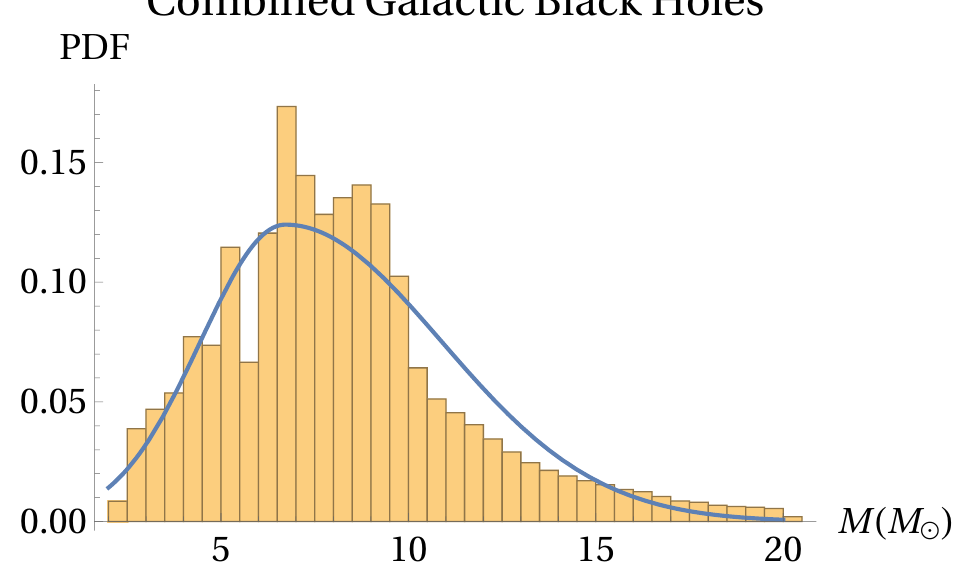
Figure 8. Mixed sample resulting from a draw of 10 6 masses from each object in Table 3 (yellow histogram) and the resulting best asymmetric Gaussian fit as AN ( 6.72,4.17,2.27 ) M (cid:12) (blue